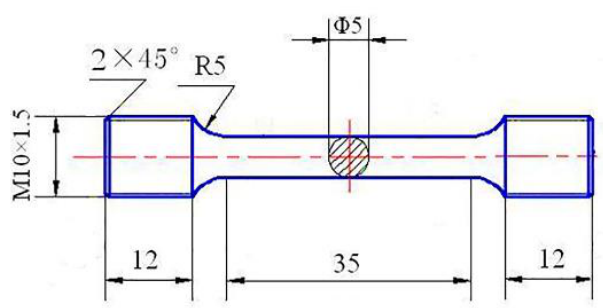
Figure 2. Sample geometry of a tensile specimen (unit: mm).